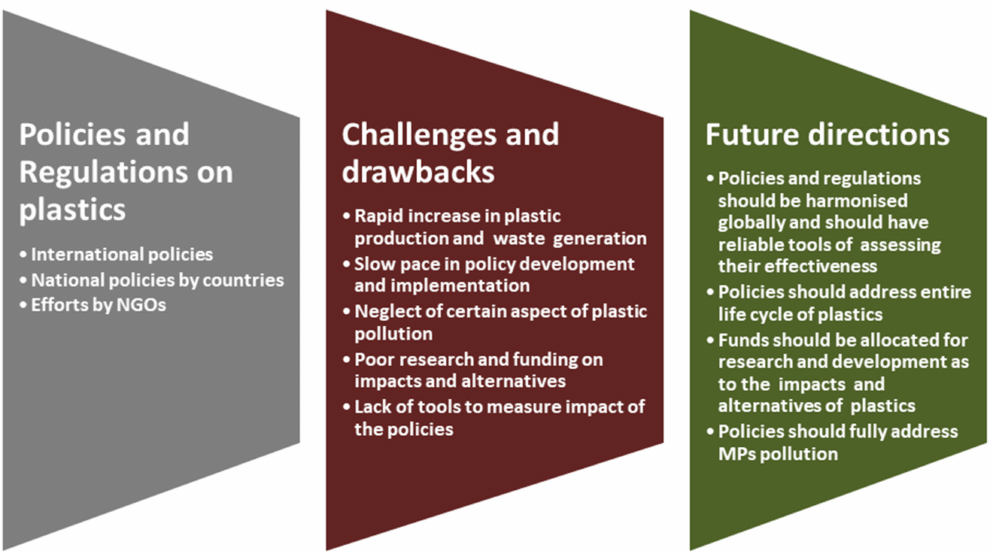
Figure 5. Summary of plastics policy and regulations, challenges, and future